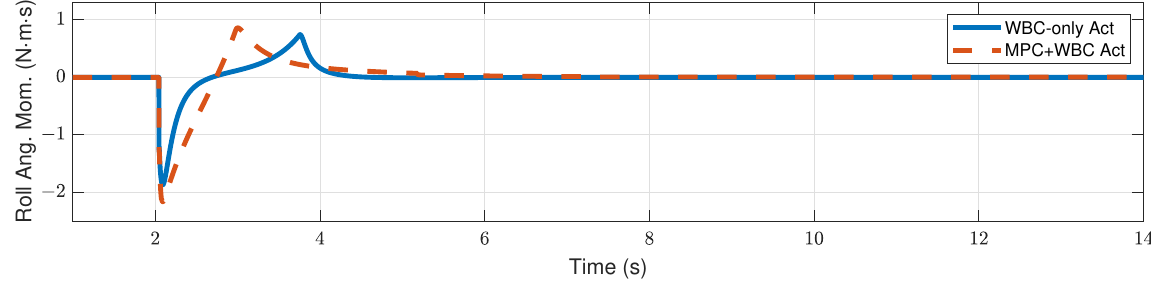
Figure 15. Swing foot position of the robot under the side impact of a 3.2 kg rigid ball.